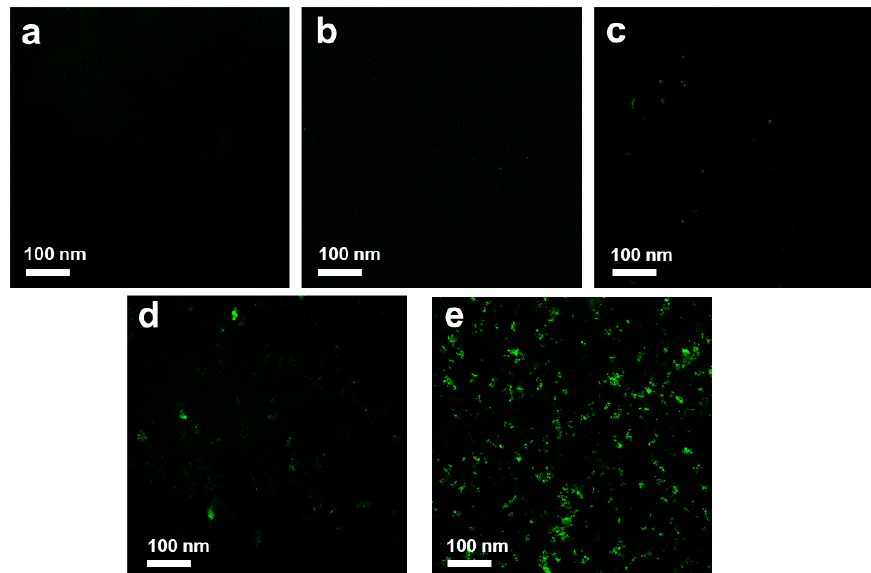
Figure 10. Reactive oxygen species (ROS) production of control ( a ), ~100 nm GO ( b ), > 1 µ m GO ( c ), ~100 nm GO–Ag NPs ( d ) and > 1 µ m GO–Ag NPs ( e ) at the same 2 h incubation time, the bacterial inhibition rates are 0.5%, 0.8%, 5.1% and 21.43% for samples ( b )–( e ), respectively.